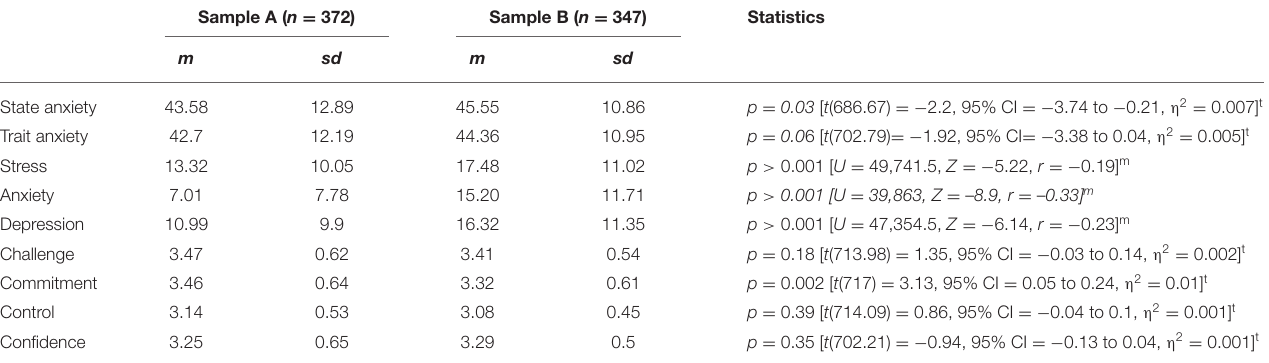
TABLE 2 | Scale averages.